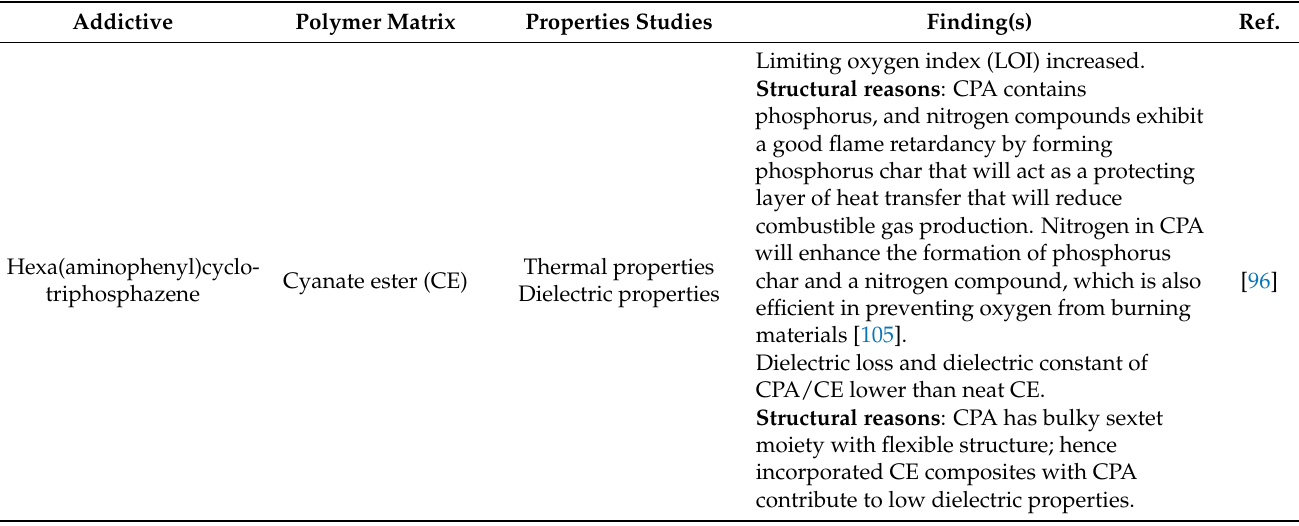
Table 5. Structural contribution of the enhancement of flame-retardant and dielectric properties. Addictive Polymer